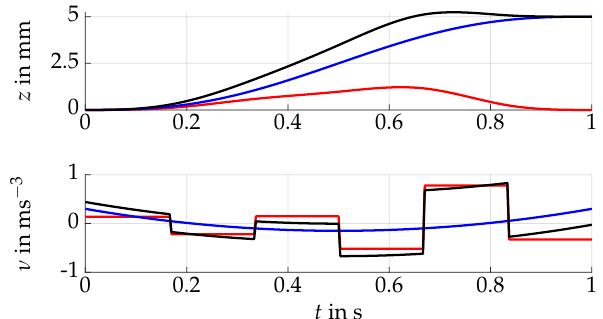
Figure 3. Superimposed proof mass trajectory that fulfills the initial and final condition up to the second order. A nominal trajectory (blue) and an optimized, piecewise constant function (red) are superimposed and result in an optimal trajectory (black). The amplitudes of the piecewise function correspond to the optimization variables σ